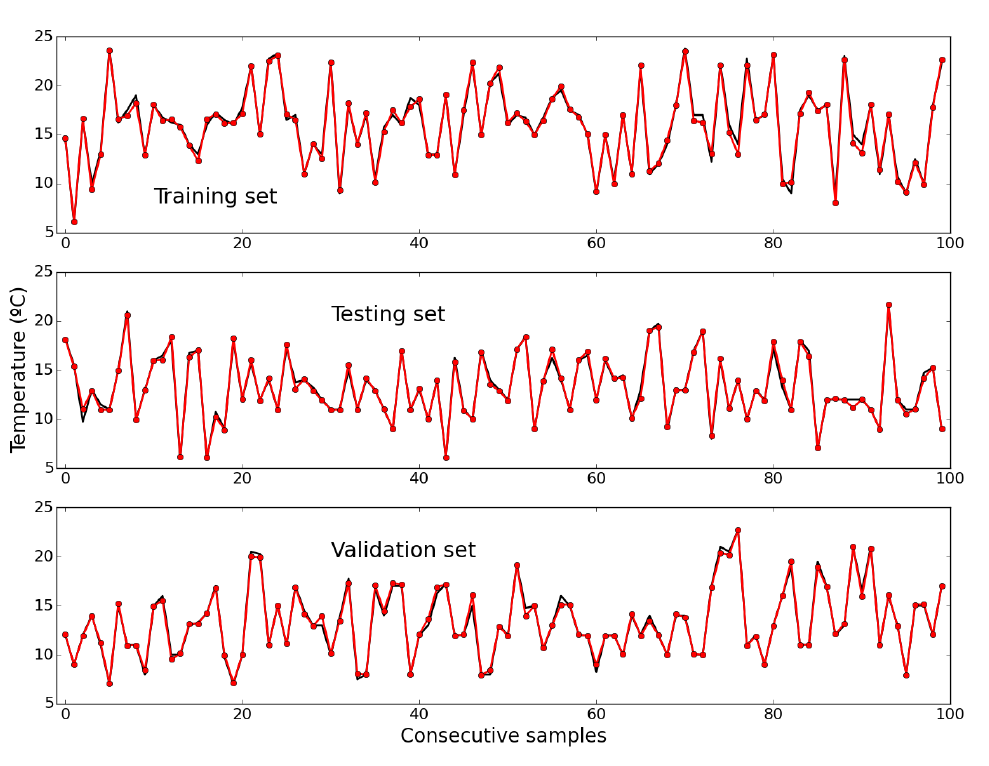
Figure 7. Measured (black) and estimated (red) values of Temperature, for the first 100 samples of the training ( Top ); testing ( Middle ); and validation ( Bottom ) data sets.